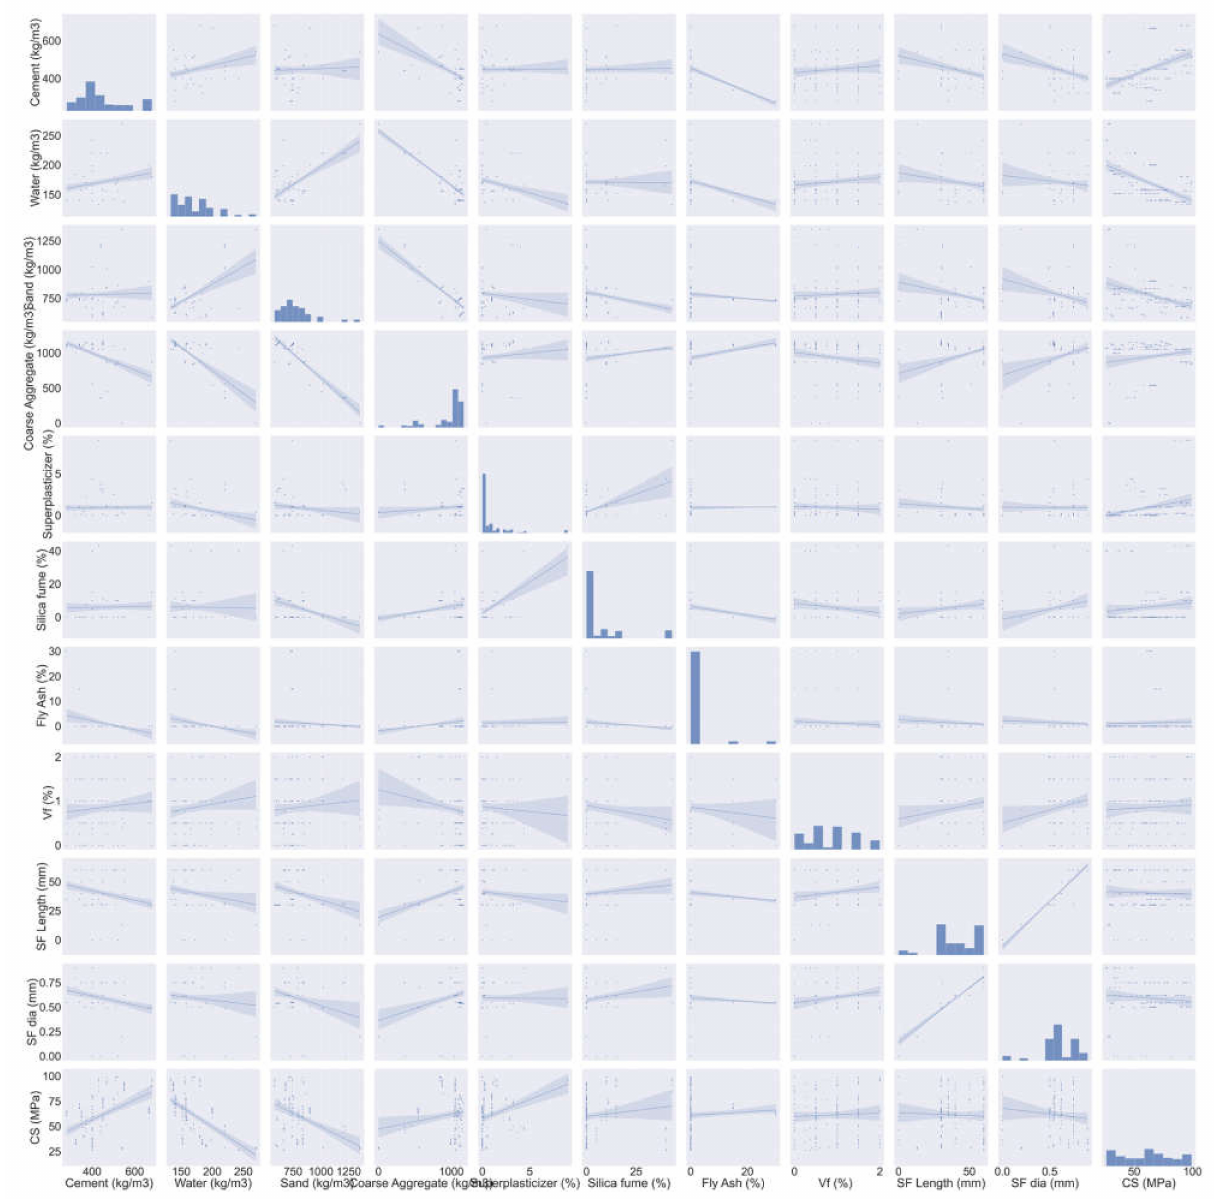
Figure 5. Description of parameter